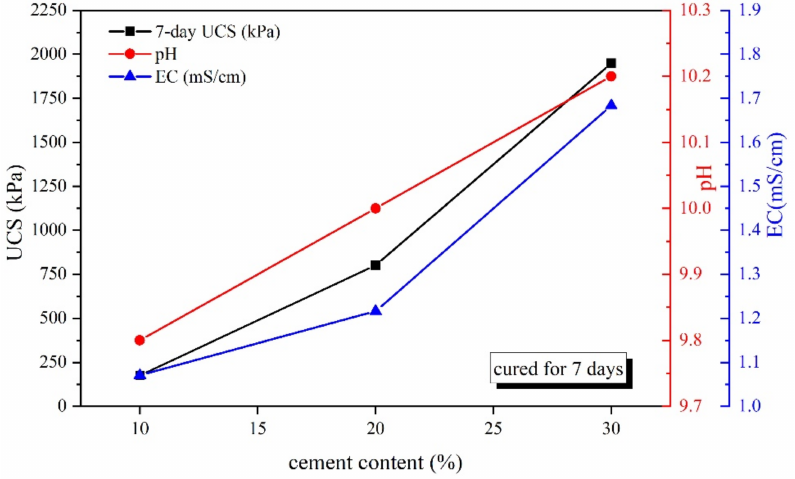
Figure 10. Relationships between cement content and UCS, pH and EC of CPDS cured for 7 days. The average pH value of 7.2 was recorded for dredged sludge, whereas the pH values corresponding to the maximum UCS of CPDS cemented by 10%, 20%, and 30% content are 9.9, 10.1, and 10.5 correspondingly. In this study, the pH value of 9.9–10.5 is appropriate for the strength development of CPDS, which is consistent with the previous studies of cement-SSP-stabilized dredged sludge (pH value of 9.9–10.0) [3]. The above observations suggest that the proper inclusion of CCR plays a positive role in providing the alkaline environment, which could be a crucial index to assess the strength gain of